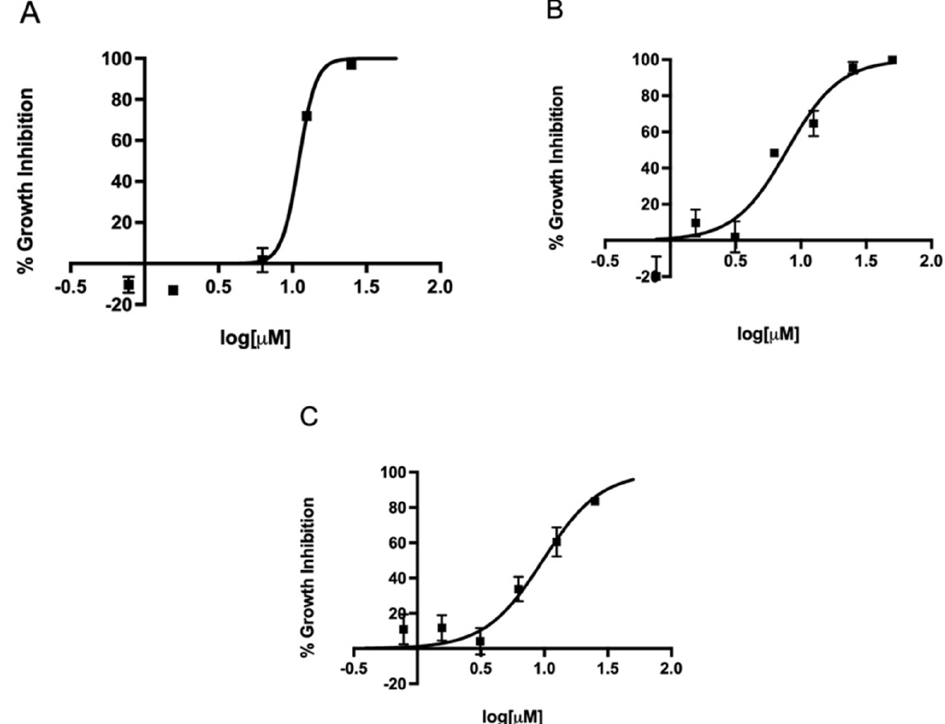
Figure 2. Concentration-dependent inhibition of growth of H. pylori by metronidazole. Strains SS1 ( A ), 60190 ( B ), and G27 ( C ) were treated with different concentrations of metronidazole for 24 h and EC 50 curves were generated from mean values of percentage growth inhibition ± SEM of metronidazole against H. pylori .